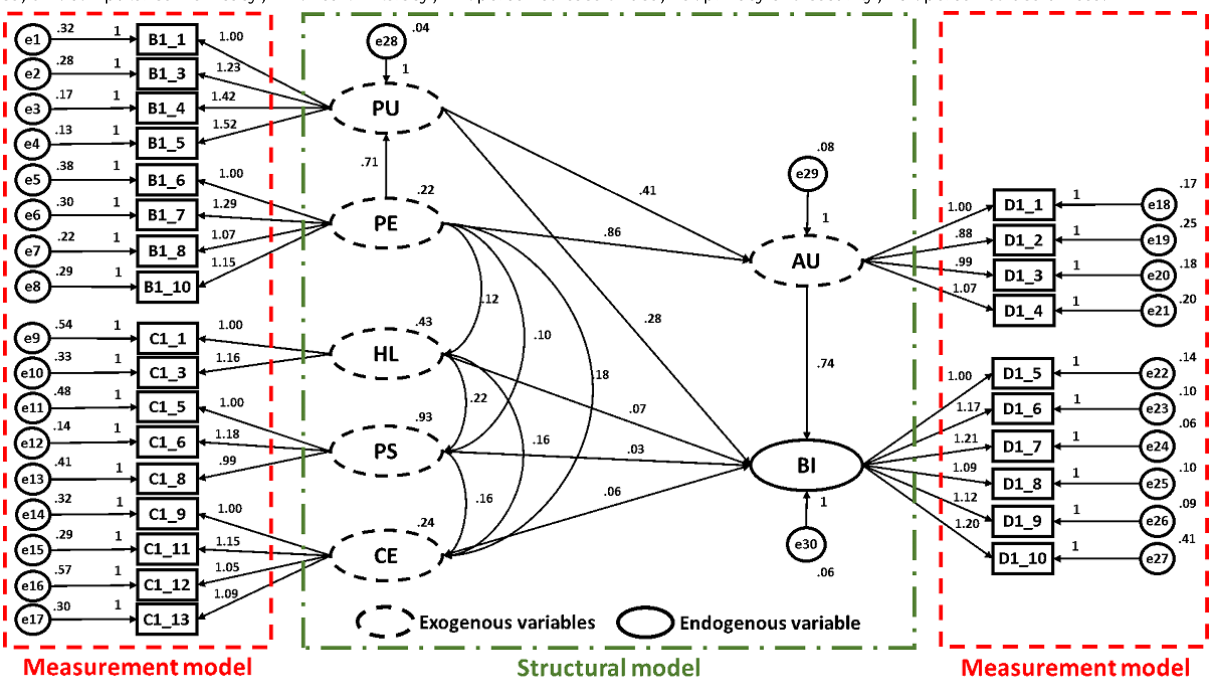
Figure 7. Path diagram of the research framework. Measured items are illustrated in rectangles (eg, B1_1); latent variables are illustrated in ovals (eg, PU); smaller circles illustrate the error of measurement (eg, e1); associations are illustrated by arrows that indicate the direction of prediction. Factor loadings are noted next to the items. Coefficients are noted for each association (ie, directional arrow). AU: attitude toward use; BI: behavioral